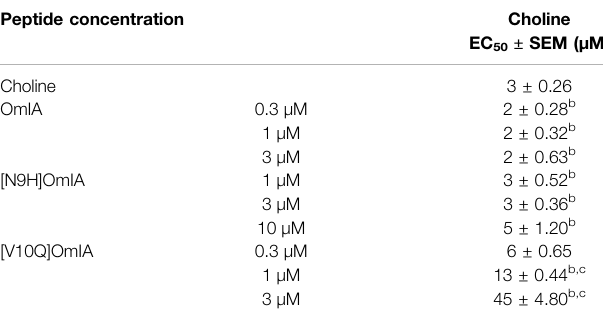
TABLE 2 | Inhibition ofcholineactivation of α 7nAChRs in SH-SY5Y cells by OmIA and analogues in the presence of PNU120596. Data represent mean ± SEM oftriplicatedatafromthreeindependentexperiments. b denotes95%CIsforcurve top values non-overlapping 100%. c denotes signi fi cant difference in EC 50 values to agonist alone ( p < 0.05). Peptide concentration